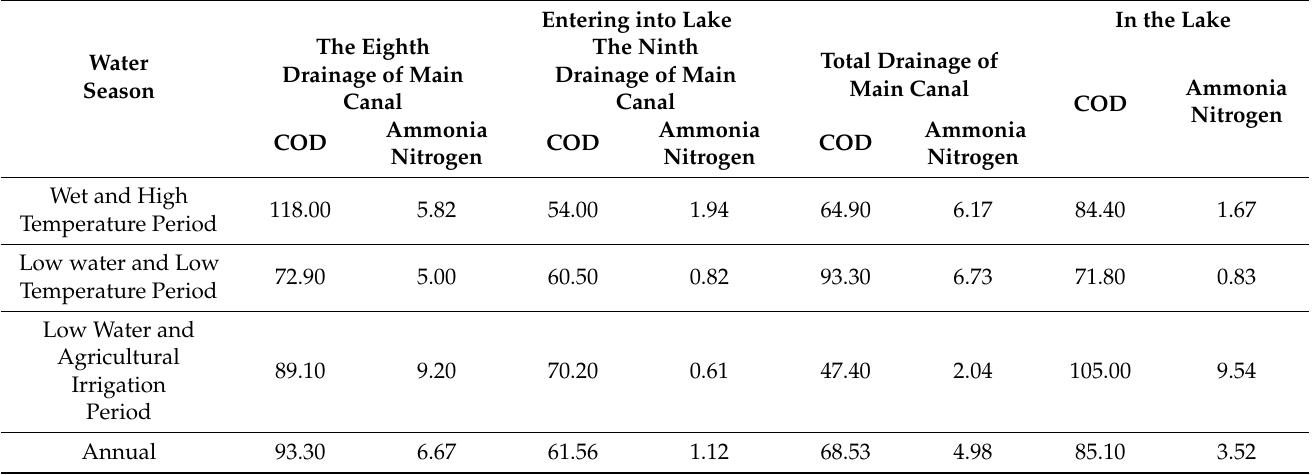
Table 1. The water quality concentrations of COD and ammonia nitrogen when entering the lake and in the lake